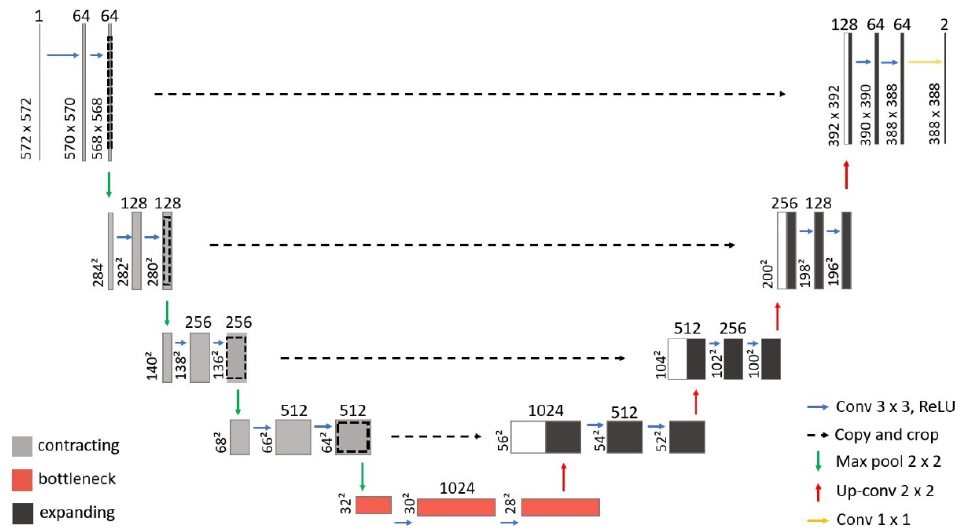
Figure 9. Illustration of U-Net based on the illustration of the U-Net framework by Ronneberger et al.